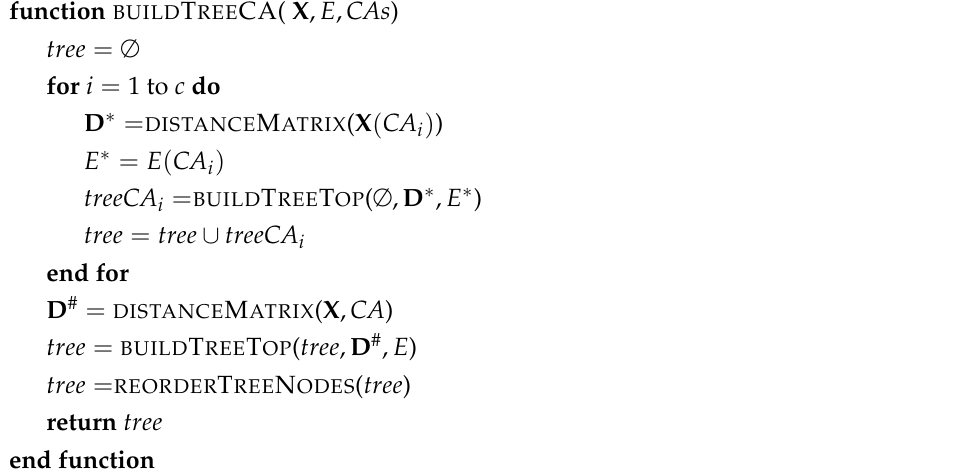
Algorithm 3 Agglomerative clustering algorithm with control area